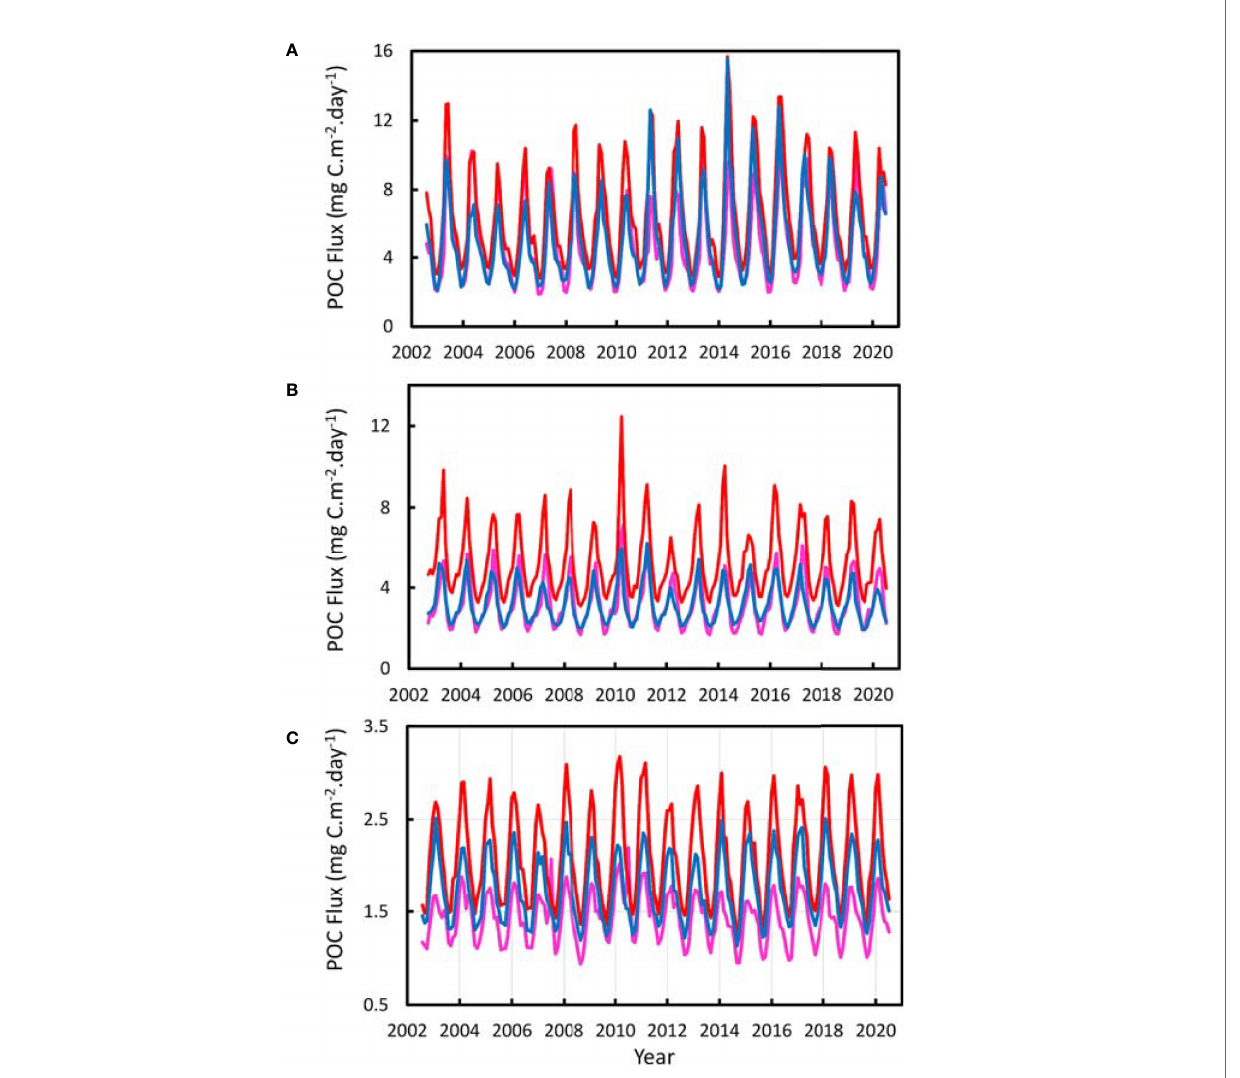
FIGURE 5 | Monthly Particulate Organic Carbon Flux (POC Flux) reaching the sea fl oor for the years 2002-2020. (A) Northern Stratum 40°-48°N, (B) Azores Stratum 32.5°-40°N, (C) Southern Stratum 10°-32.5°N. Red line - MAR Polygon, Pink line – West Polygon. Blue line - East